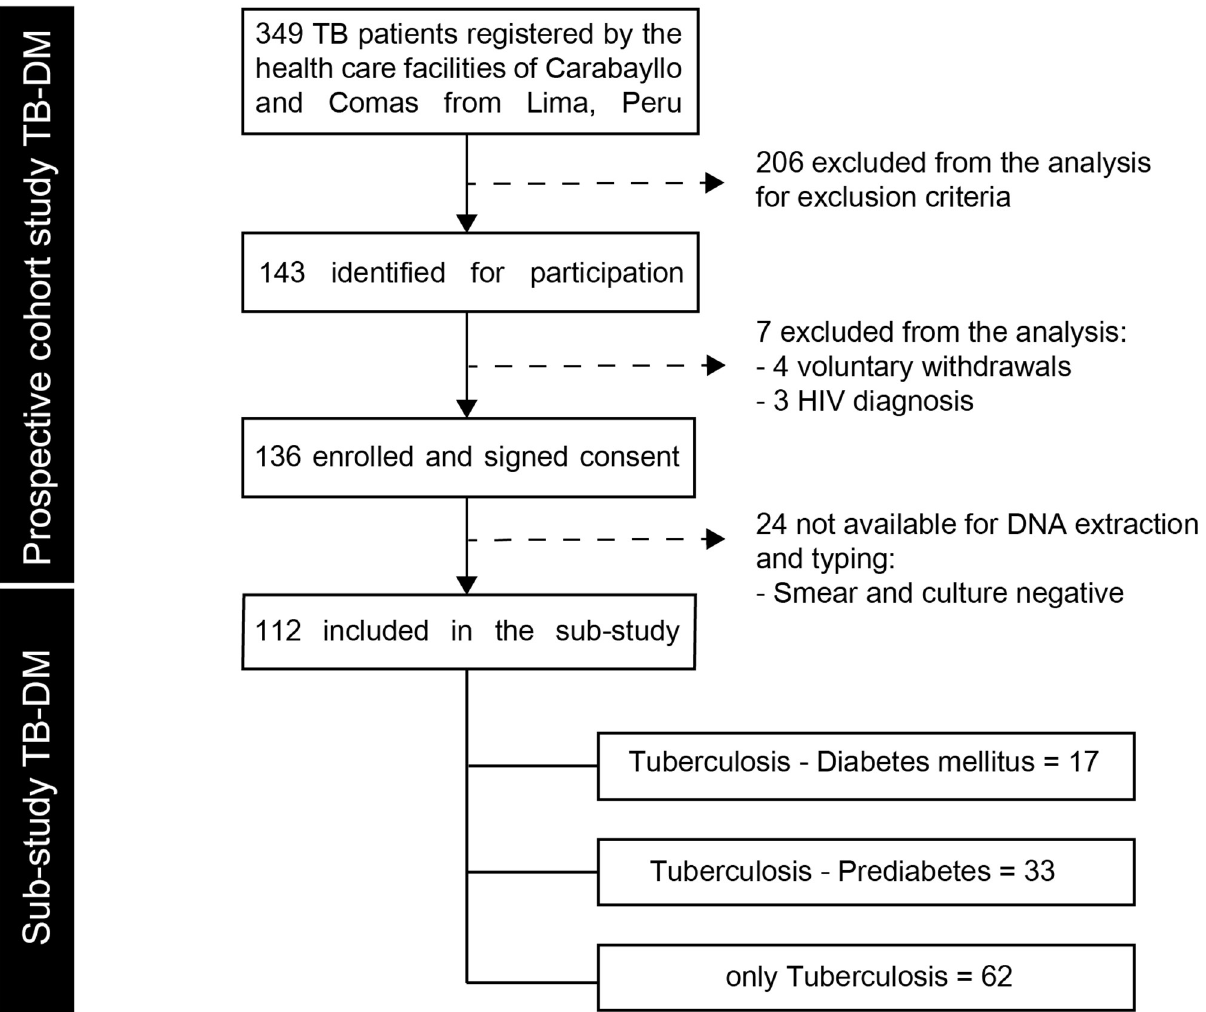
Fig 1. Flowchart of the study population. TB: pulmonary tuberculosis, DM: diabetes mellitus, PDM: prediabetes.